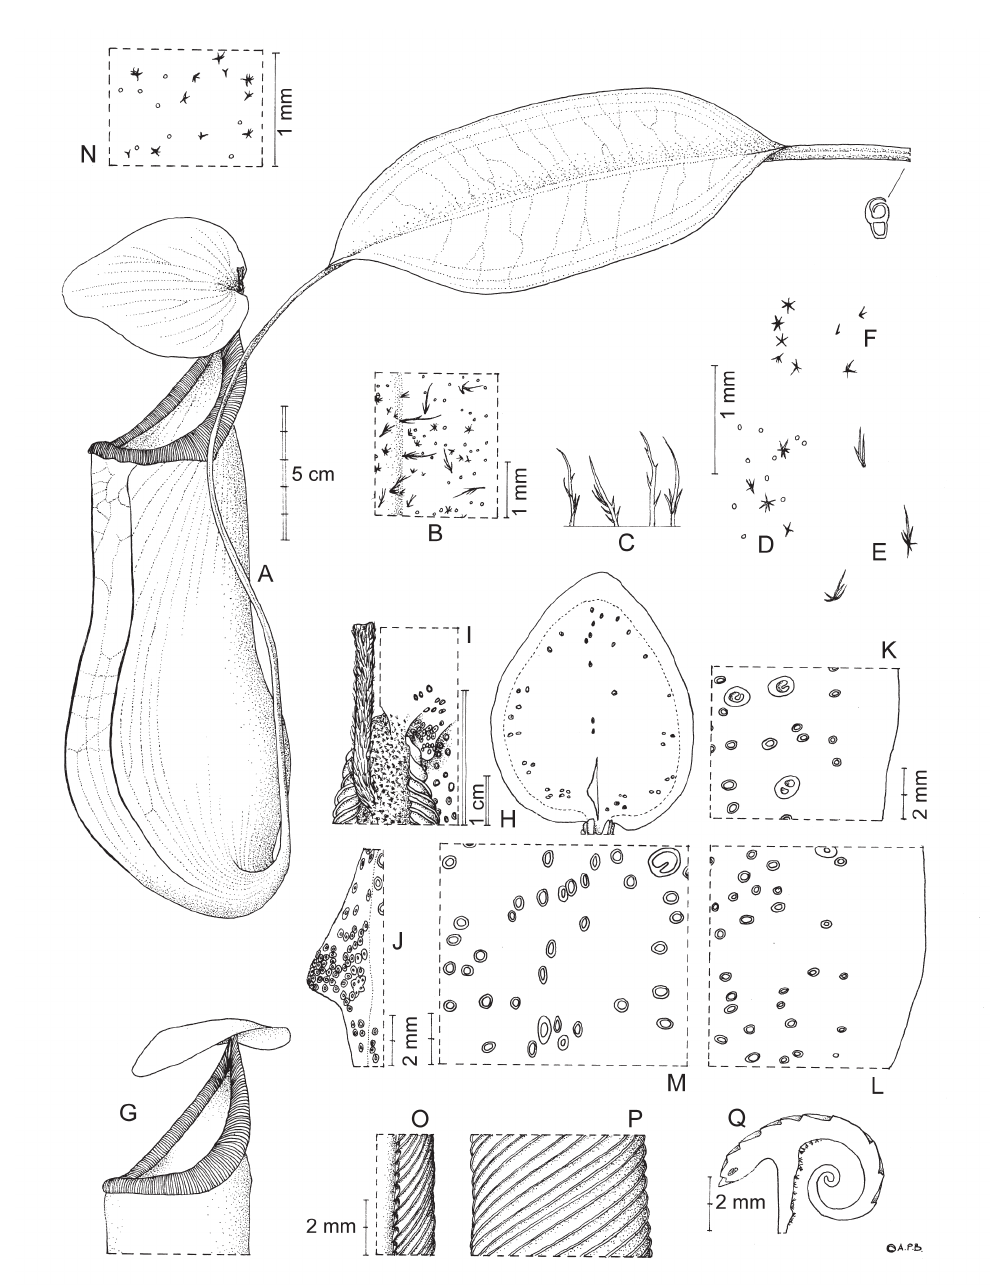
Fig. 3. Nepenthes extincta sp. nov. A . Habit, showing intermediate pitcher. B . Indumentum, lower surface of blade (midrib on left). C . Branched bristle hairs (detail from lower surface of blade). D . Stellate hairs and sessile glands (detail from lower surface of blade). E . Branched erect hairs (detail from lower surface of blade). F . Stellate hairs, with appressed arms, leaf-blade lower surface, near midrib. G . Upper part of intermediate pitcher, lid posture as in life. H . Lower surface of upper pitcher lid. I . Basal lid appendage and spur. J . Basal lid appendage and ridge, side view. K-M . Details of nectar glands, lower lid surface. N . Indumentum, outer surface of pitcher. O . Peristome, view from inside pitcher showing minute teeth and holes at edge. P . Peristome, view from above. Q . Transverse section of peristome (outer surface on right). A–F & H–Q from Konta 12365 , G from sketch by M. Cheek. Scale bars: double, graduated = 5 cm; single = 1 mm; single graduated = 2 or 3 mm as indicated. All drawn by Andrew